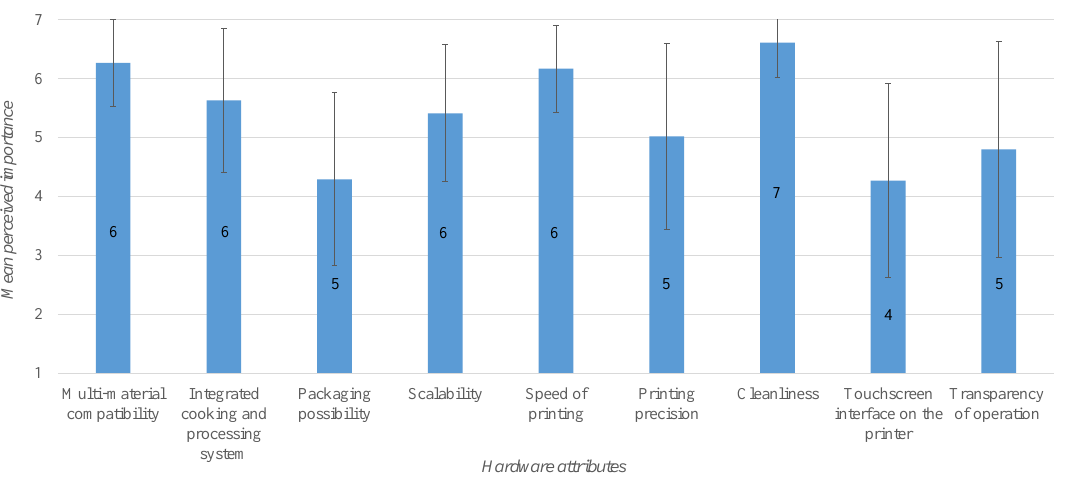
Figure 4. Barplotofmeansforperceivedimportanceof3Dfoodprinterhardwareattributes. Errorindicates the standard deviation, and the number inside the bars indicates median. Bars sharing the same letter are not significantly different according to Wilcoxon signed rank